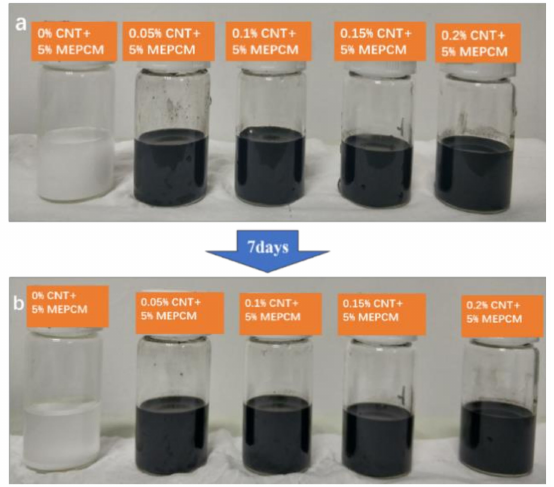
Figure 6. Typical sedimentation photographs of the suspension: ( a ) 0 day and ( b ) 7 days.